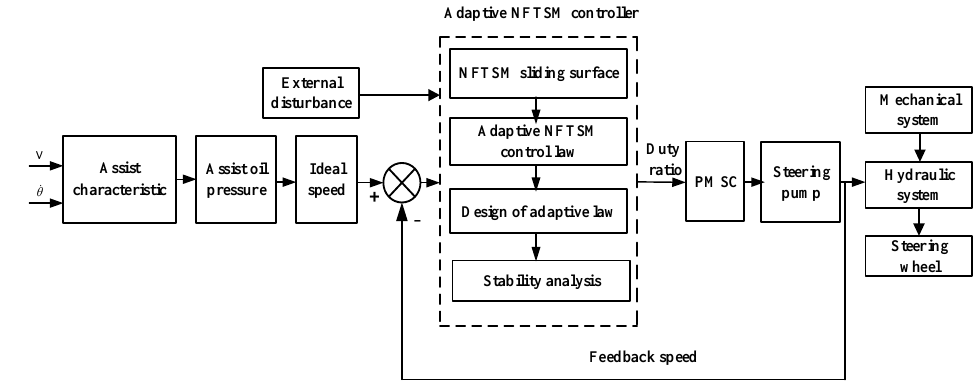
Figure 7. Control Strategy diagram of P-ECHPS.